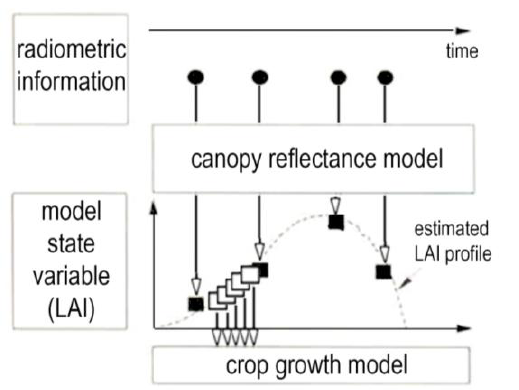
Figure 9. Schematic description of the ―forcing‖ method. The complete time profile of a crop state variable (here: LAI ) is reconstructed from remote sensing data and introduced into the dynamic crop growth model at each time step in the simulation (from Delecolle et al.